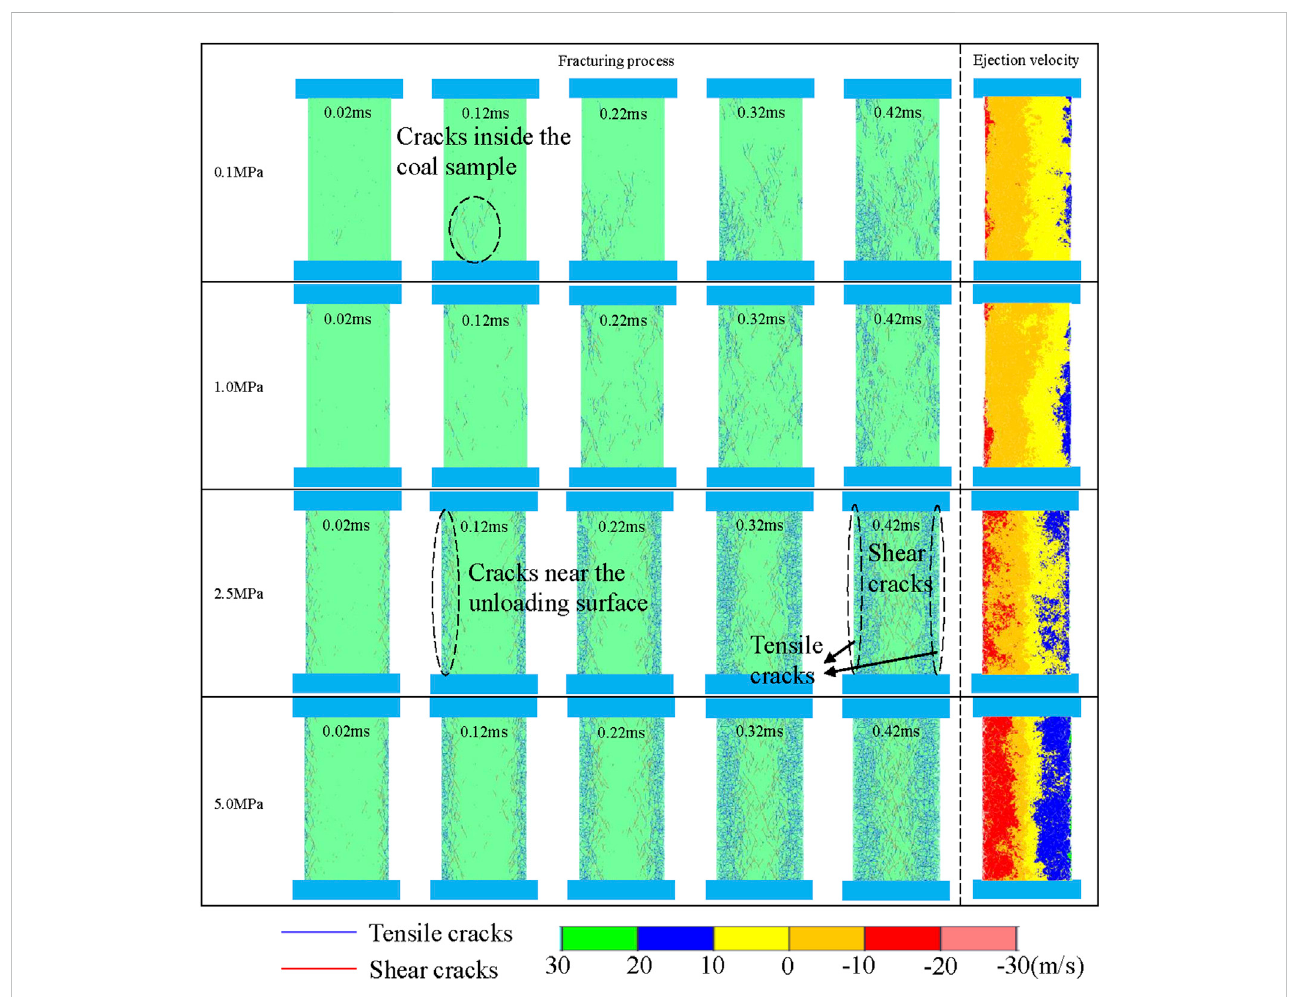
FIGURE 5 Crack development process of coalburst under different pre-con fi ning pressures: (A) .1 MPa; (B) 1 MPa; (C) 2.5 MPa and (D) 5 MPa. Note: blue lines indicate tensile cracks, and red lines indicate